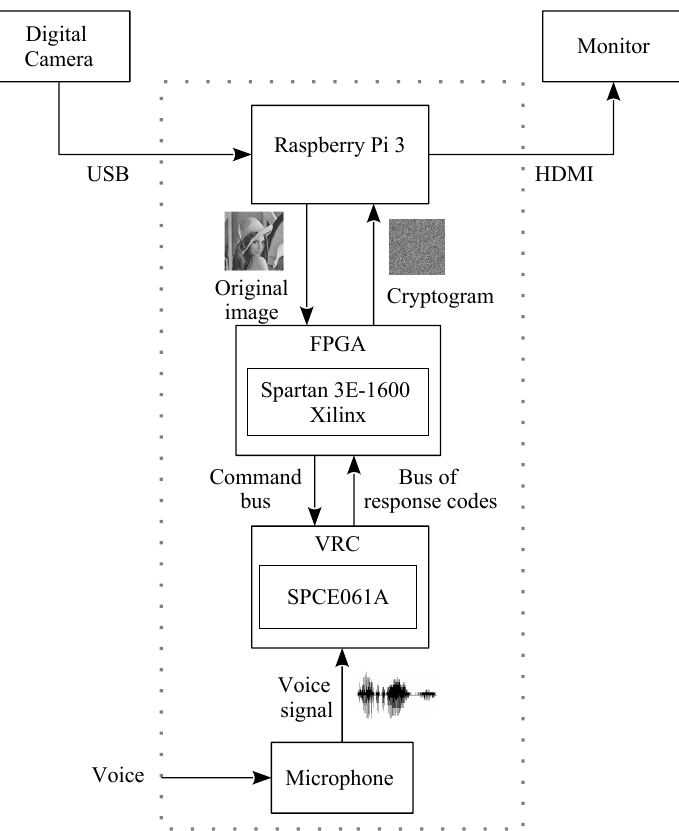
Figure 1. Block diagram of the proposed embedded